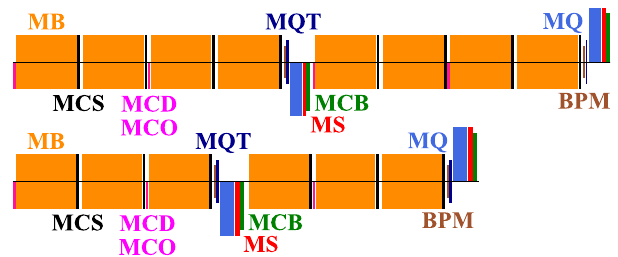
FIG. 12. Arc-cell layout of the 18 × 90 (upper) and 23 × 90 (lower) design. In both arc-cell designs, MBs are each equipped with a sextupole spool piece corrector (MCS). Similar as in LHC, an octupole (MCO) and a decapole (MCD) corrector are placed after every two MBs. Next to the main quadrupole (MQ), a trim quadrupole (MQT), an orbit corrector (MCB), a main sextupole (MS), and a beam position monitor (BPM) are located. Focusing and defocusing quadrupoles are represented by bars being located below and above the horizontal axis, respectively.